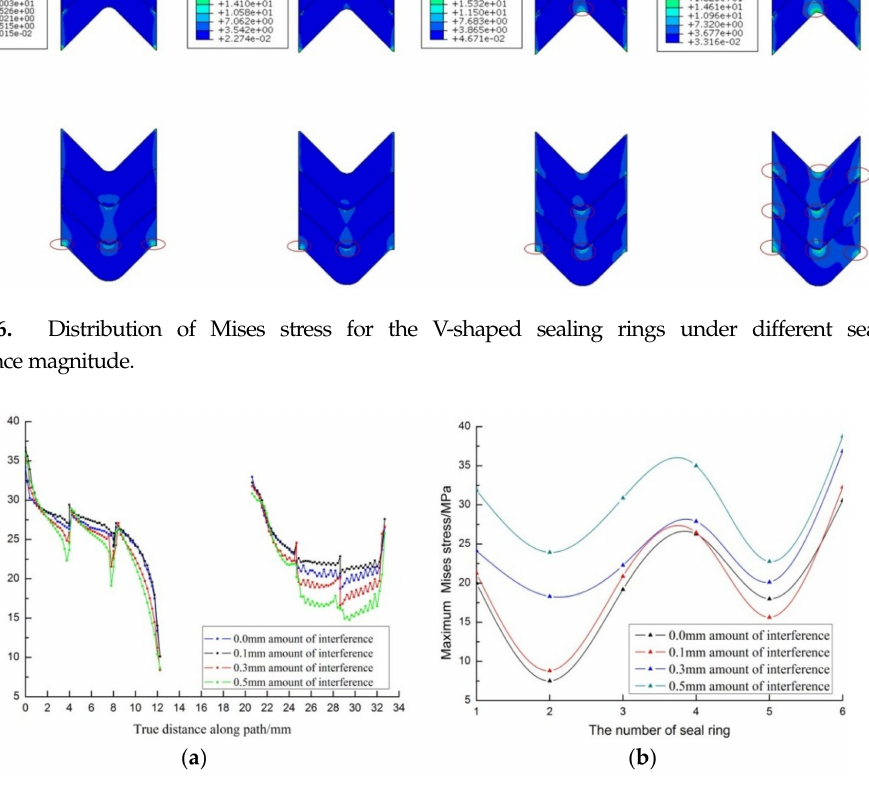
Figure 7. The stress distribution curve of sealing rings under different sealing interference magnitude: ( a ) contact stress distribution curve; ( b ) Mises stress distribution